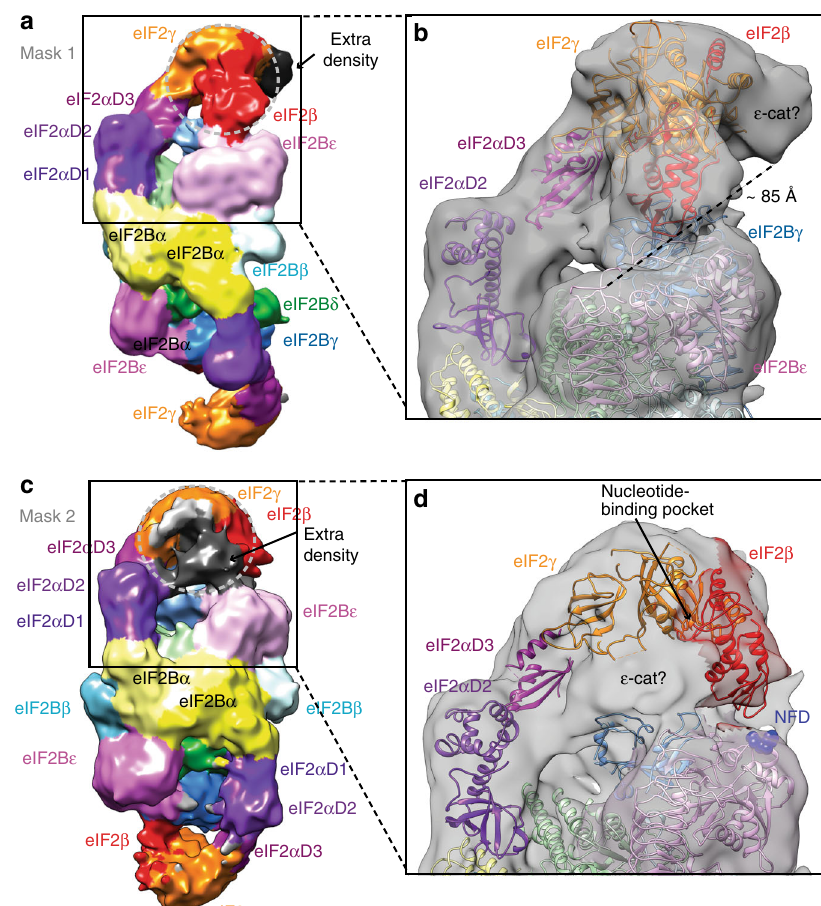
Fig. 4 Extra densities in the maps after masked classi fi cation in proximity of eIF2 γ could accommodate eIF2B ε -cat HEAT domain with eIF2. a Map B of eIF2B – eIF2( α P) complex obtained by masked classi fi cation around eIF2 γ and β showing extra density in contact with eIF2 γ . b The extra density in map B could accommodate most of the ε -cat HEAT domain and would be in contact with eIF2 γ domains III and G away from nucleotide-binding site. ~85 Å distance separates this extra density from the C terminus of the eIF2B ε and is just enough for the 73 residues linker (res. 472 – 544) to connect ε -cat with the rest of eIF2B ε . c Map D of eIF2B – eIF2( α P) complex obtained by masked classi fi cation around eIF2 γ and an extra density seen at a lower threshold (black) in proximity of nucleotide-binding pocket. d The size and shape of the extra density in map D could fully account for the whole ε -cat HEAT domain. Also, in this map, eIF2 β approaches the NFD motif (blue spheres) in eIF2B